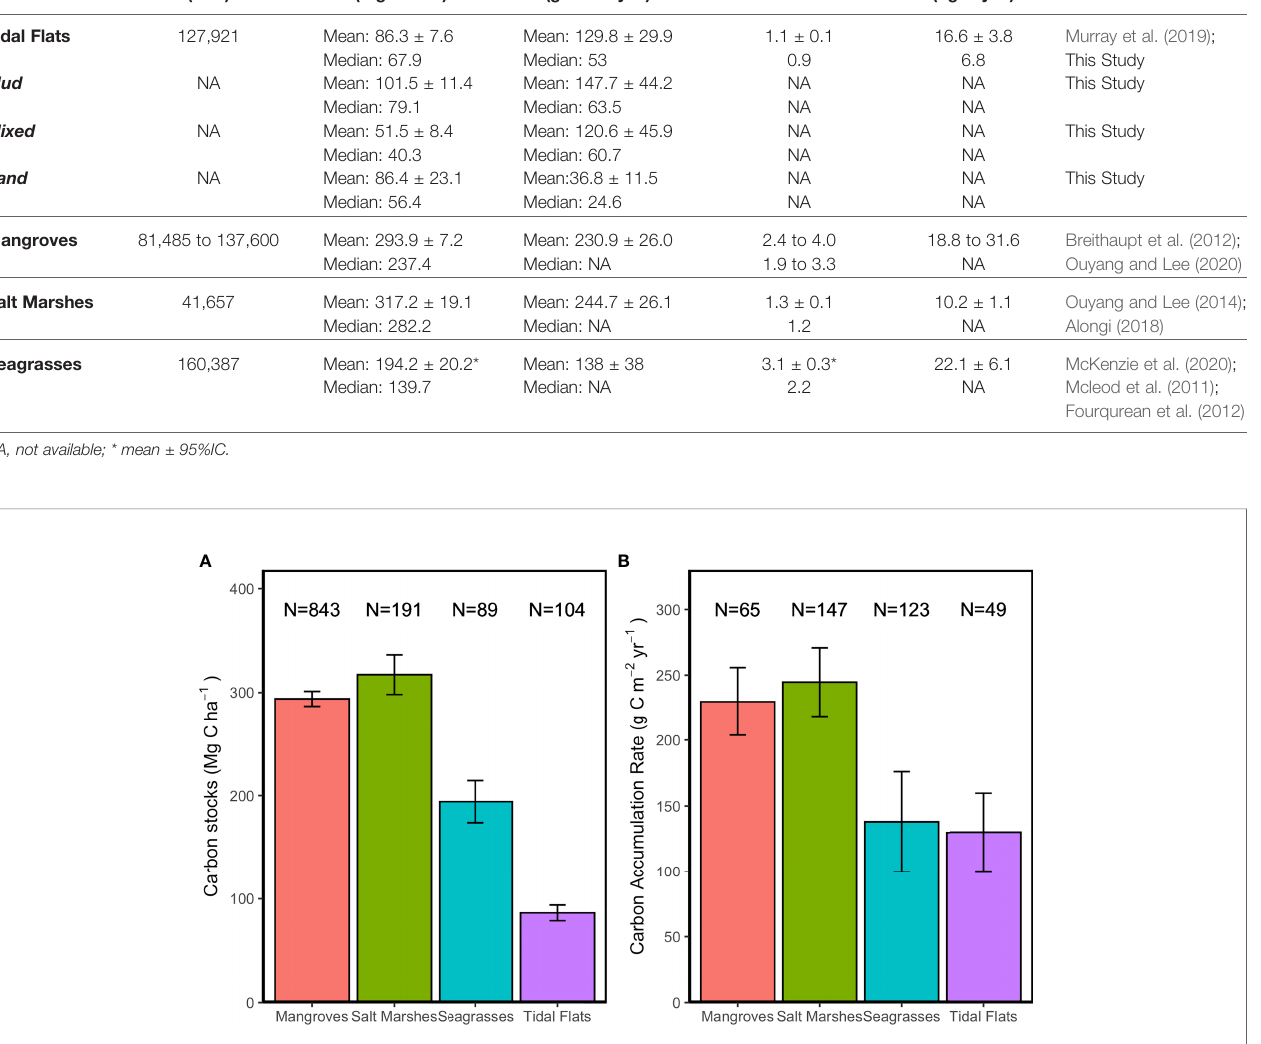
FIGURE 2 | Comparison of sediment C sequestration in global mangroves, salt marshes and tidal fl ats. (A) Comparison of sediment C stocks (mean ± SE) in mangroves, salt marshes, seagrass meadows and tidal fl ats. C stocks data of seagrass is presented in C stock (mean ± 95% CI). (B) Comparison of CAR (mean ± SE) in mangroves (OC), salt marshes, seagrass meadows and tidal fl ats.